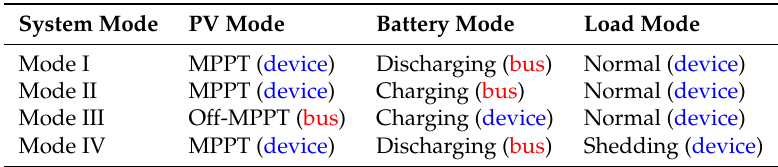
Table 1. Operating modes of the standalone DC microgrid.